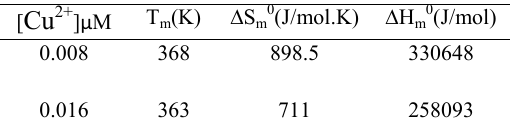
Proteinase K has positive charges at pH=7[16].